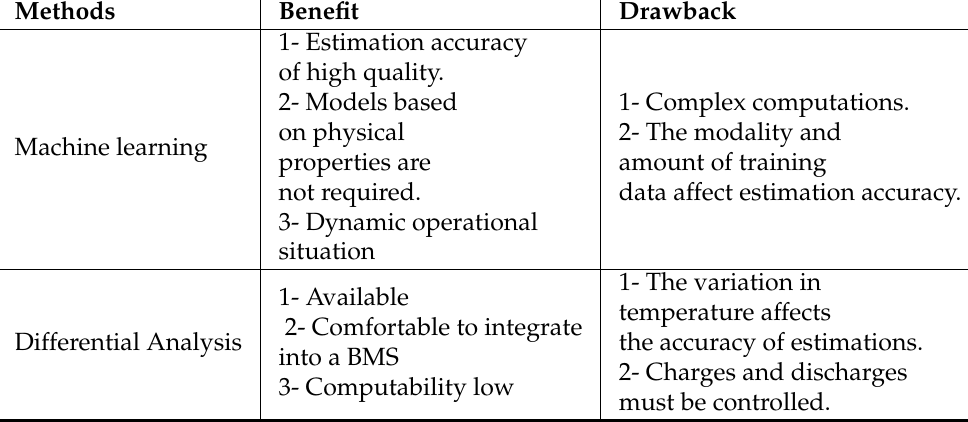
Table 7. Comparing SOC estimation techniques—benefits and